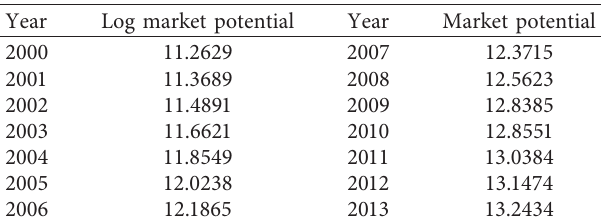
Table 3: Log market potential value of cities in China,